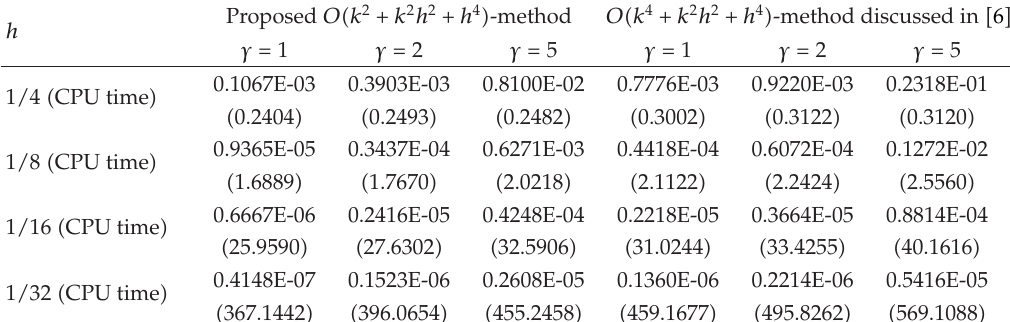
Table 5: Example 6.5: The maximum absolute errors (cid:4) with CPU time (cid:5)